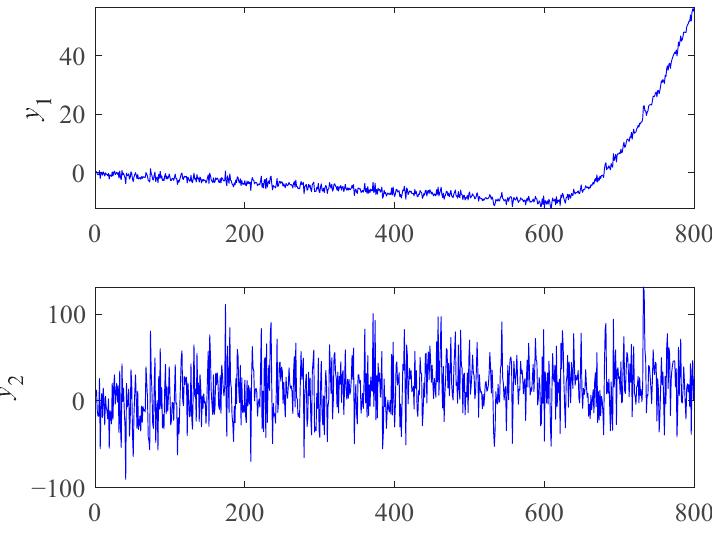
Figure 2. Plots of simulation data. Table 1. The trendability evaluated by Spearman coefficient and ARMI. Data Spearman